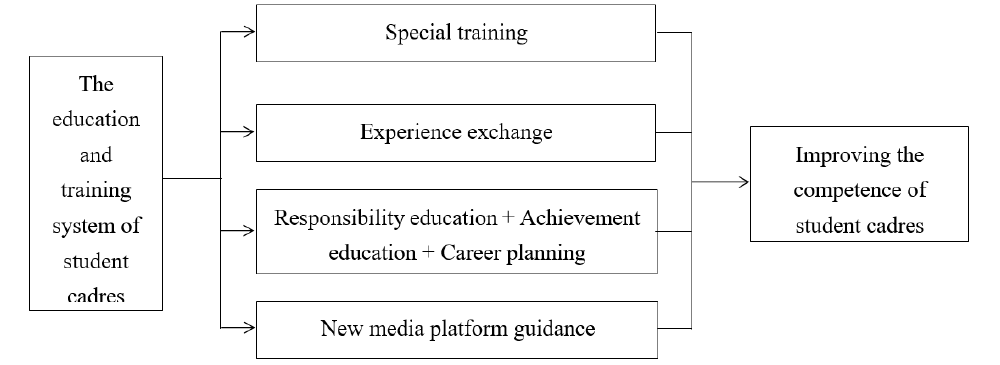
Fig. 1 Improving the education and training system of student